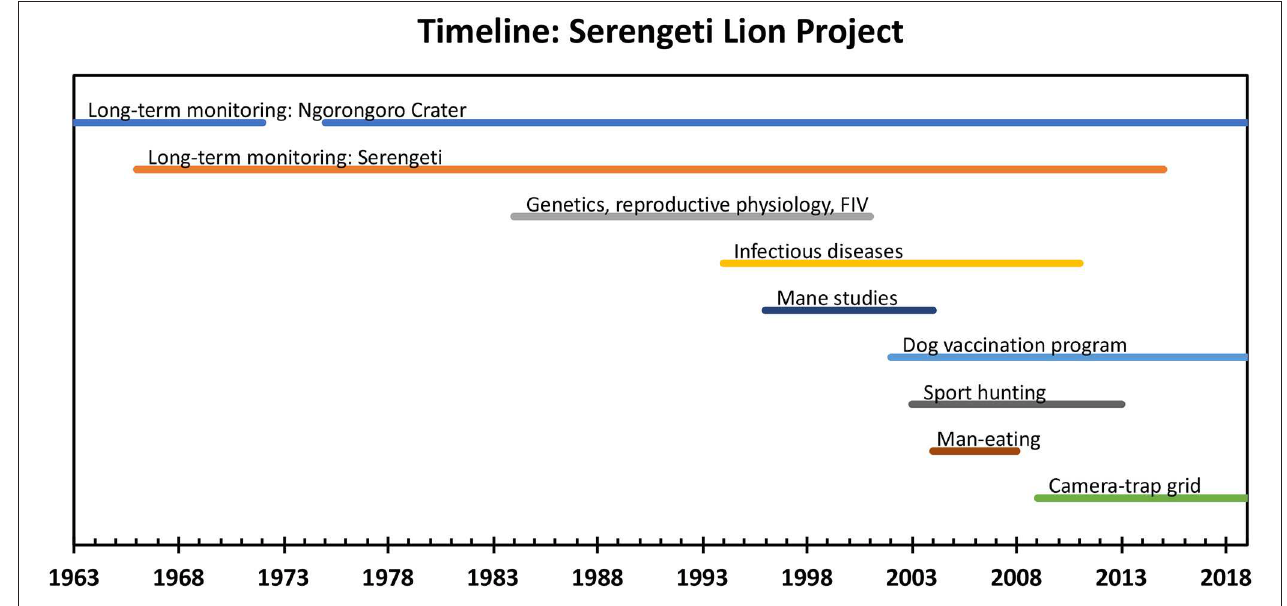
FIGURE 1 | Sequence of activities between 1963 and 2018. Continuous monitoring of the Serengeti lions began in 1966; retrospective monitoring of the Crater lions was achieved by soliciting photographs from staff, tourists and scientists who spent various periods of time in the area between 1963 and 1972; continuous on-the-ground monitoring began in 1975. The genetics, physiology and retrovirus studies were conducted in collaboration with the Laboratory of Viral Carcinogenesis and the Smithsonian. Infectious disease studies were performed with vets from the US and Switzerland. The mane studies involved assistance from a Dutch toy company, American dermatologists and the makers of an IR camera. The dog vaccination program was initiated in collaboration with vets from the UK and continued by an American zoo and US vet school. The sport-hunting work was developed in cooperation with computer scientists and Tanzanian wildlife authorities. The man-eating studies involved the Tanzanian government and American social scientists. The large-scale camera-trap work was implemented in collaboration with an online Citizen Science platform, The Zooniverse.